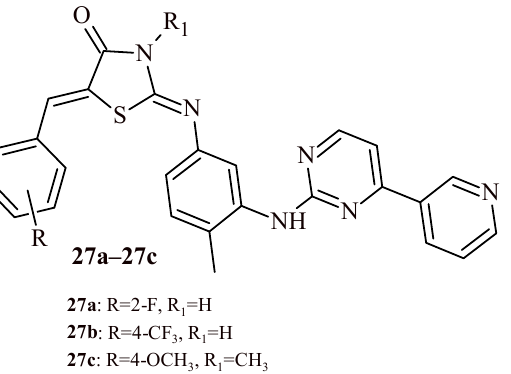
Figure 14. The thiazolidine-4-one-phenylaminopyrimidine hybrids with antileukemic activity. The series of isatin-based thiazolidin-4-one derivatives was synthesized and evaluated for their anticancer activity against three cancer cell lines (HepG2, MCF-7 and HT-29). The best activities among the series were found for Compounds 28a and 28b (Figure 15). The Compound 28a was active against HepG2, MCF-7 and HT-29 at half maximal inhibitory concentration of 27.59, 8.97 and 5.42 µ M, respectively. While Compound 28b